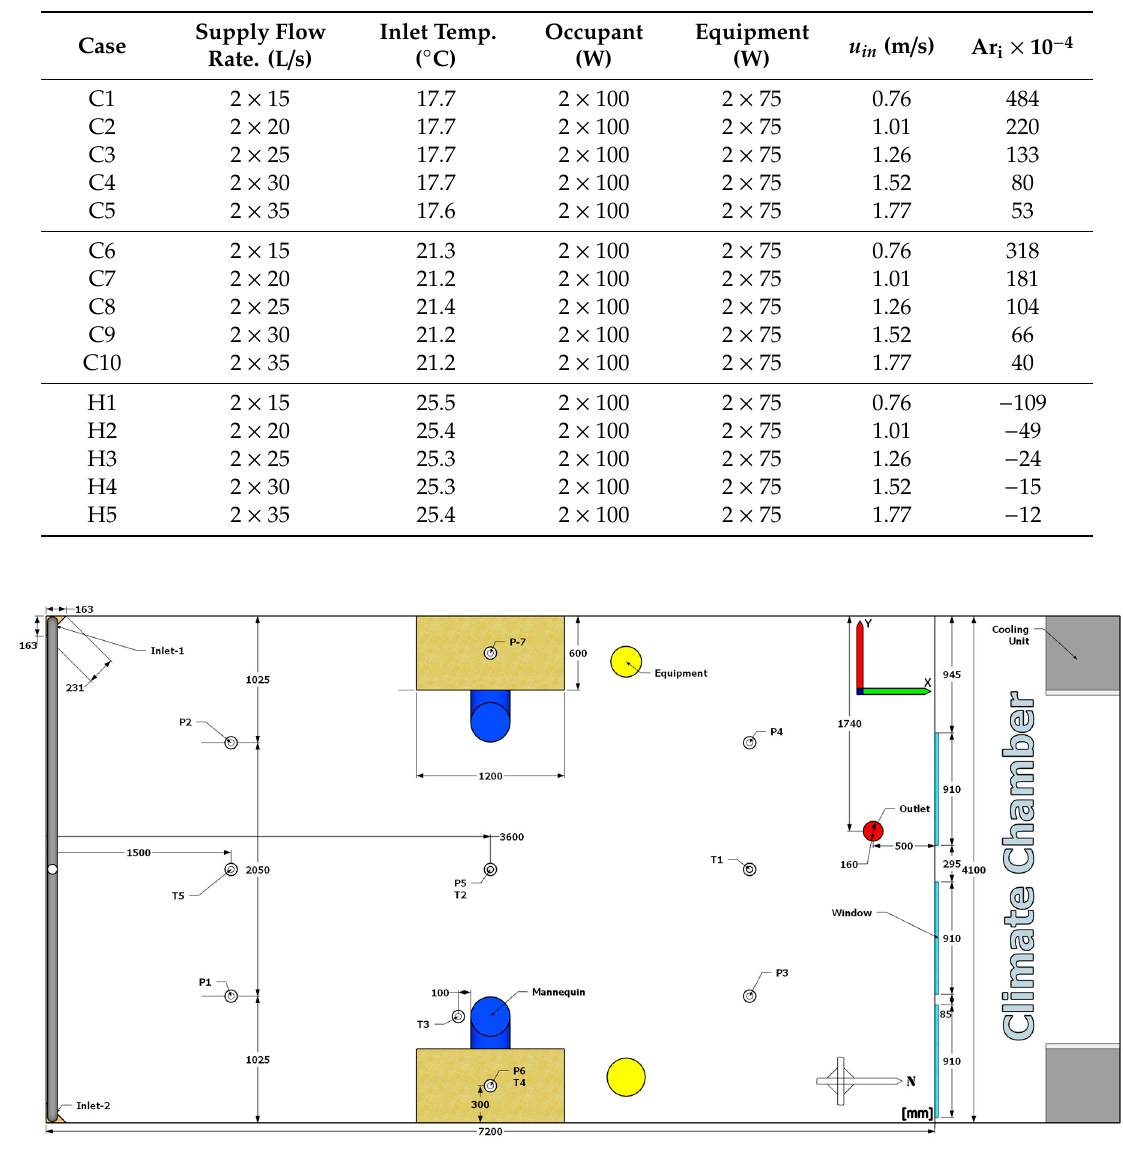
Figure 2. Measurement positions and schematic top-view layout of the o ffi ce room, including the climate chamber, which is the same layout as in [22].